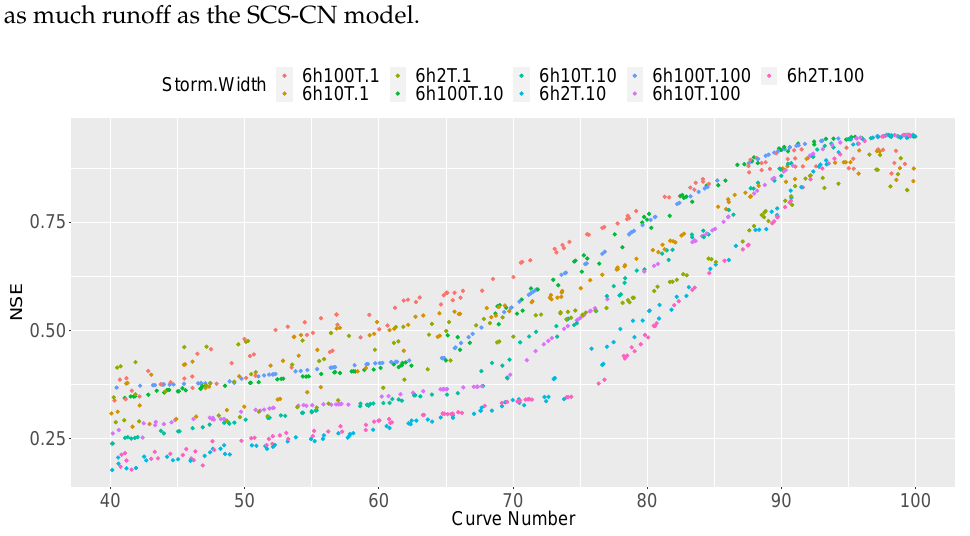
Figure 7. Computed NSE values after calibration. Different colours are used for each combination of storm depth and catchment